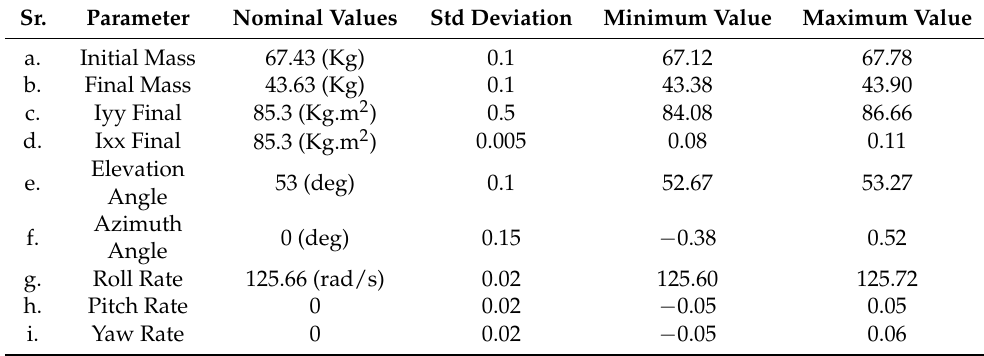
Table 1. Initial Conditions and Error